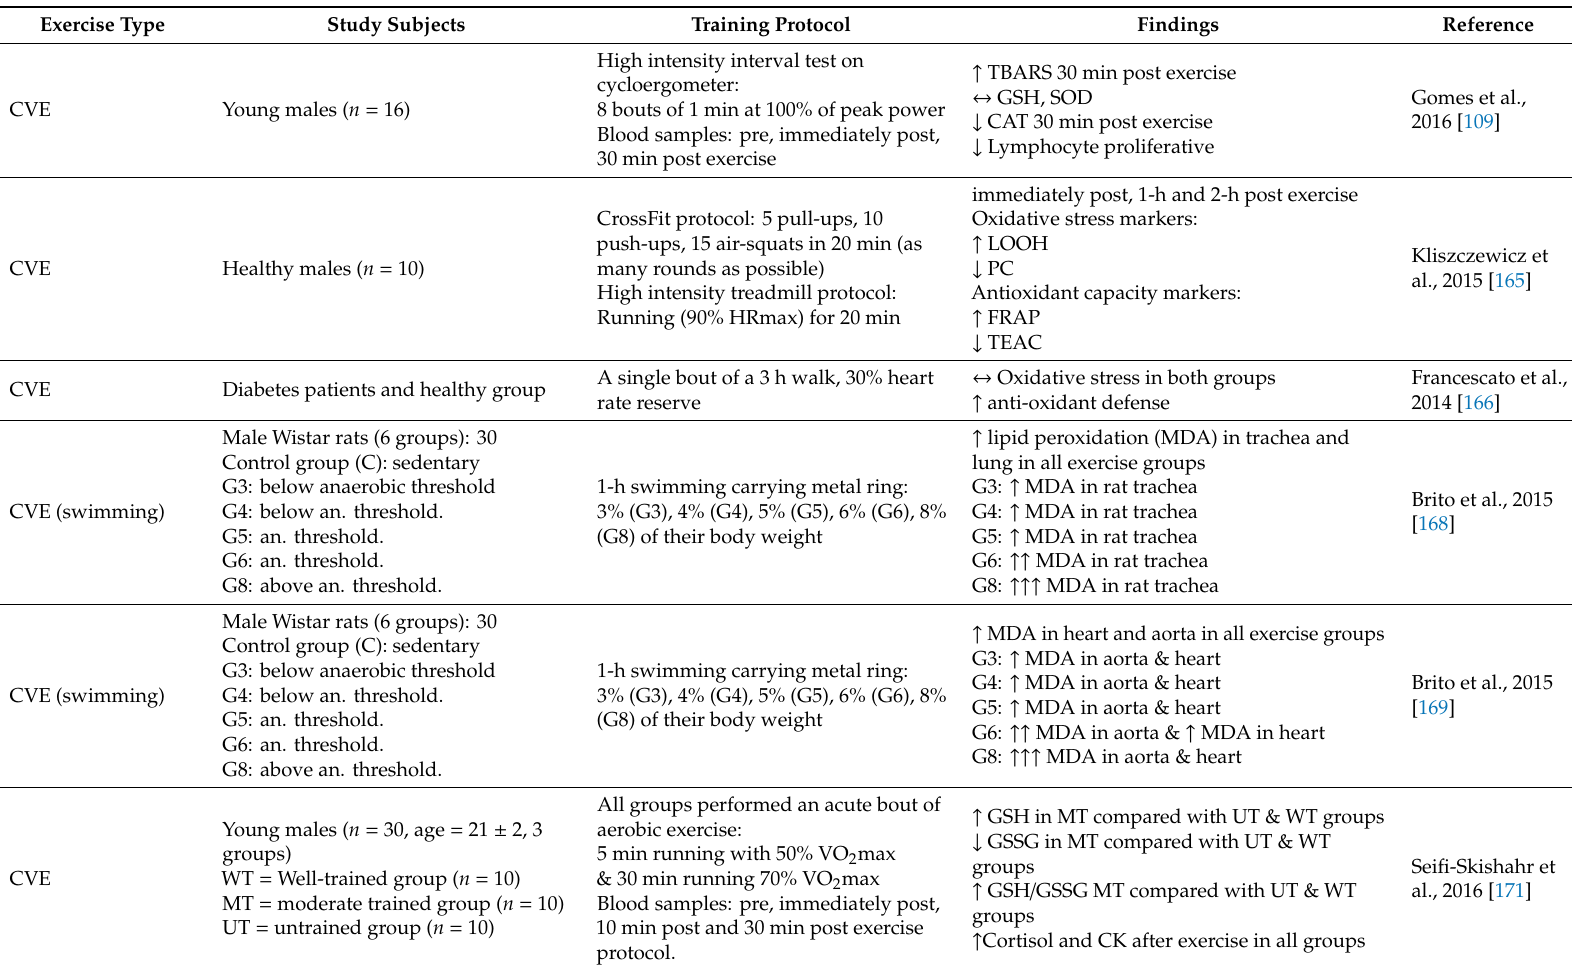
Table 1. E ff ects of Acute Exercise on Redox